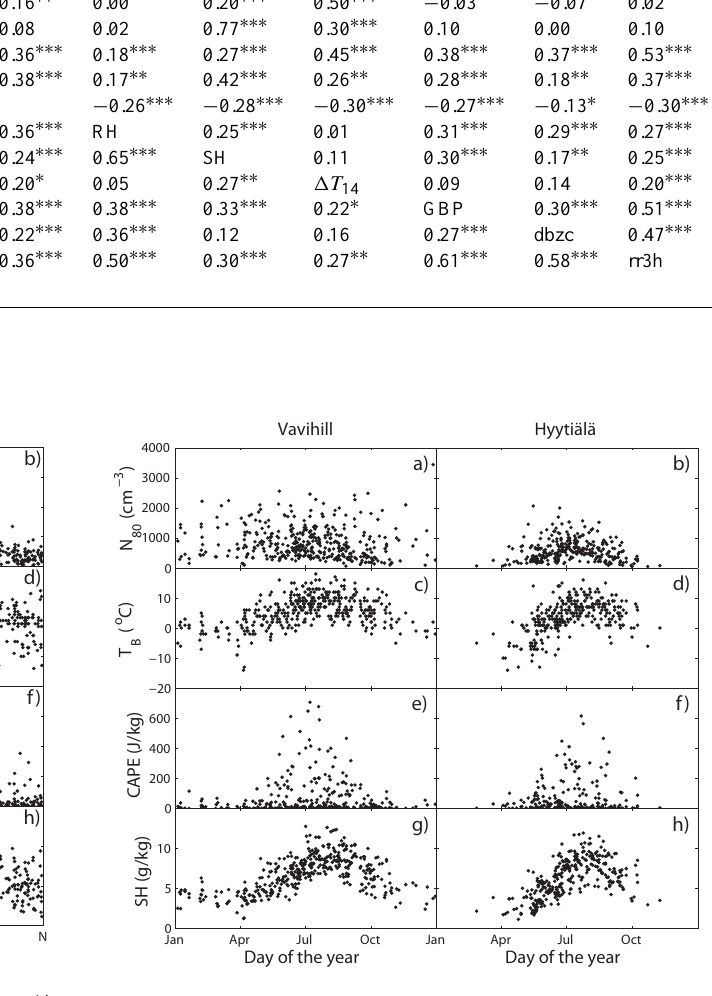
Fig. 3. The figure shows how the parameters in Fig. 2 vary over the